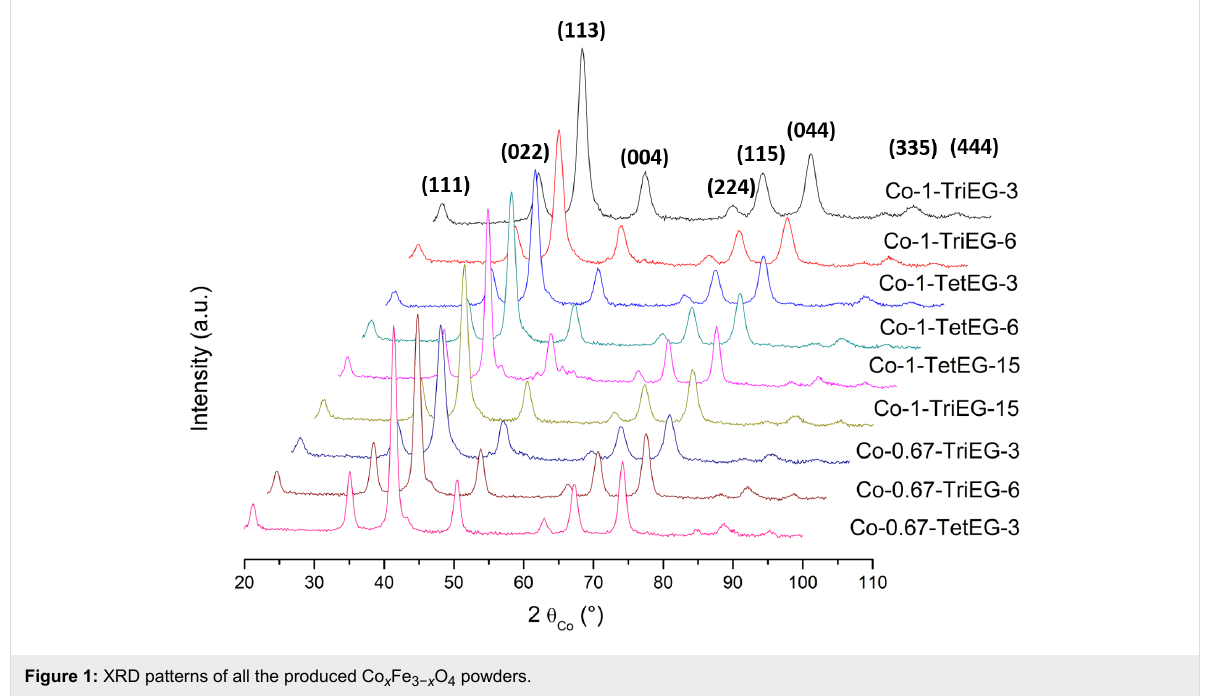
Figure 1: XRD patterns of all the produced Co x Fe 3 − x O 4 powders.